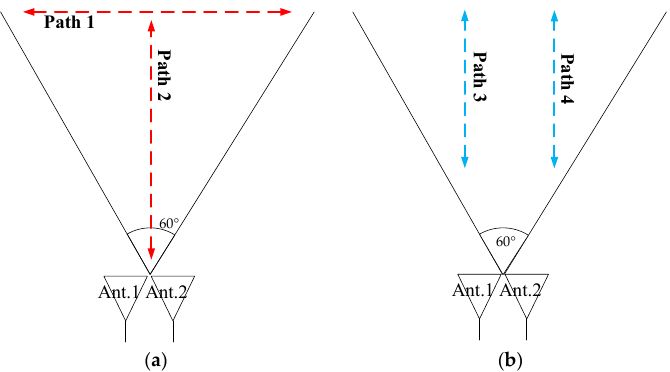
Figure 14. Illustration of the designed flight paths for the drones, ( a ) horizontal flight in Path 1 for Experiment 1, and vertical flight in Path 2 for Experiment 2; ( b ) two vertical paths for Experiment 3.